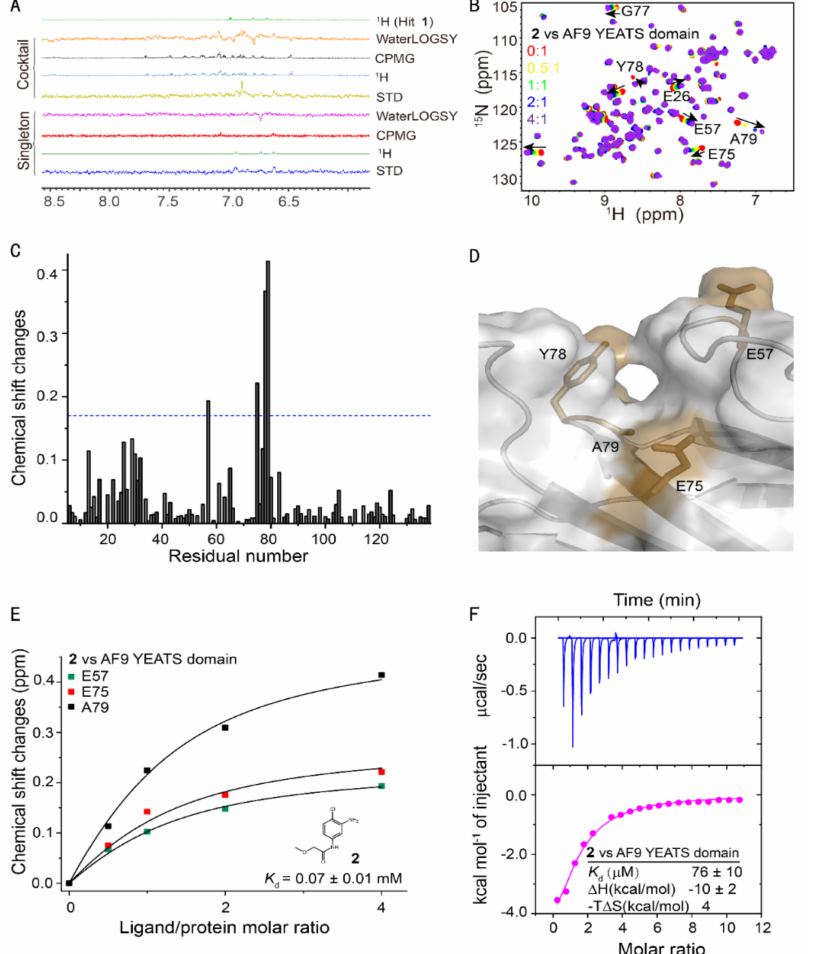
Figure 1. Fragment-based screening against the AF9 YEATS domain. ( A ) NMR fragment-based screening spectra for a typical cocktail and the identified hits of AF9 YEATS in a phosphate